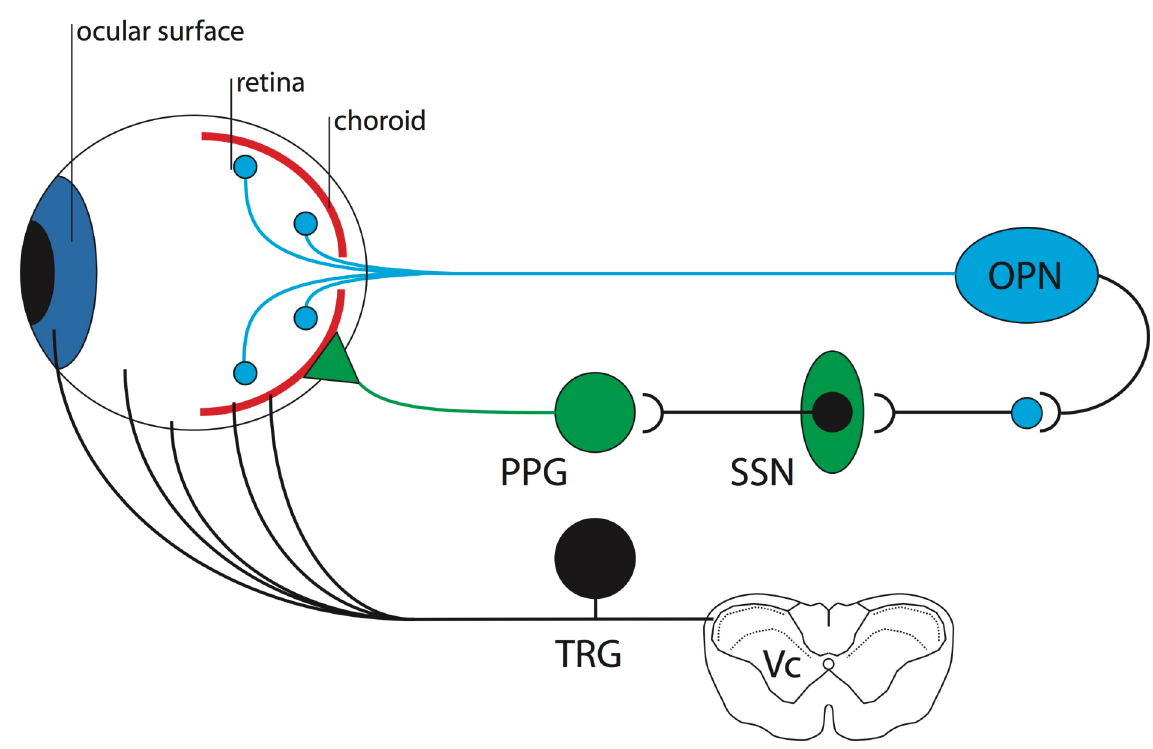
Figure 3: The proposed model for light-induced activation of trigeminal